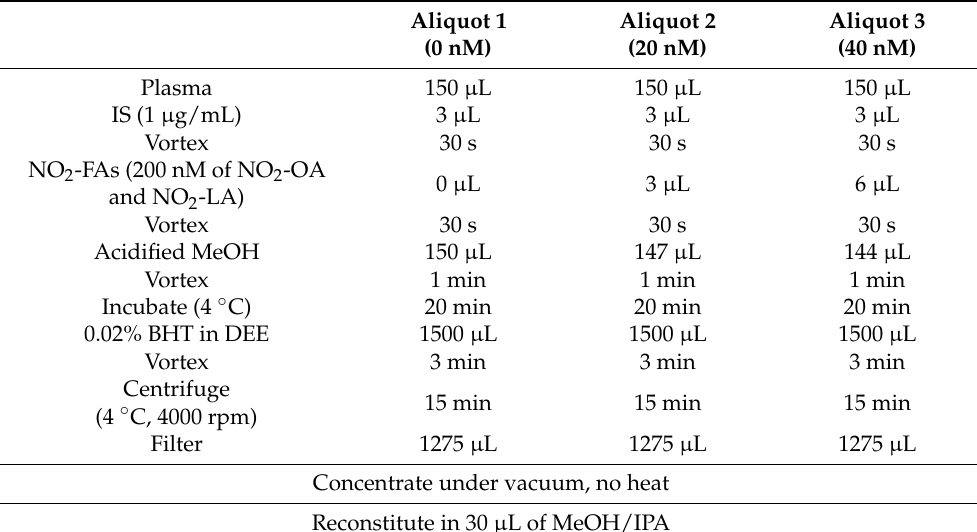
Table 3. Plasma lipid extraction and standard addition protocol for the quantification of NO 2 -FAs in